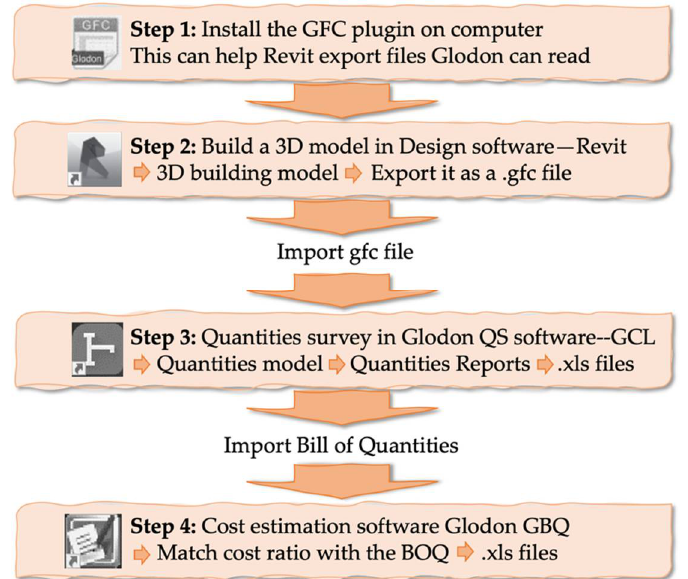
Figure 10. A technical workflow showing the cost estimation process using selected tools.